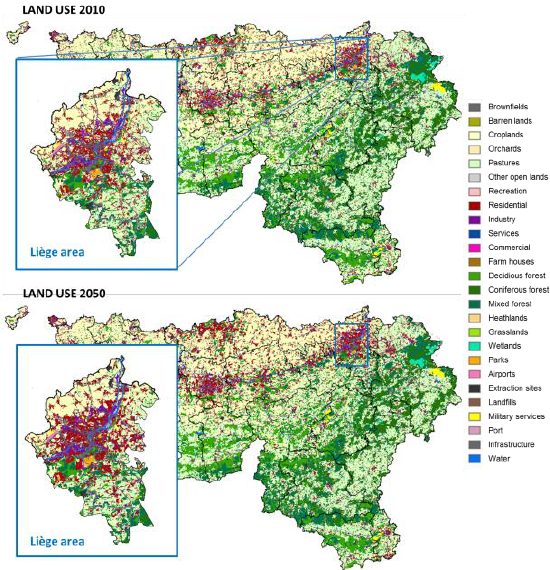
Figure 4. Preliminary results of land use change between 2010 and 2050 in Wallonia